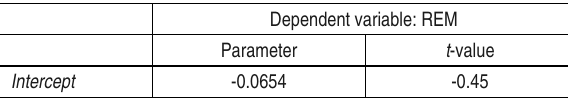
Table 4. The relation between